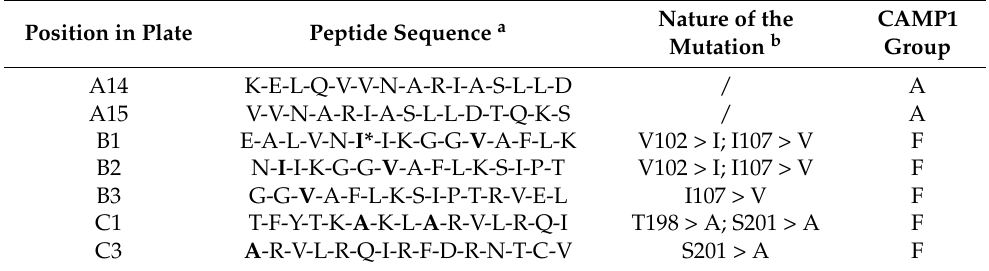
Table 1. CAMP1 peptide sequence recognized by TLR-2. Position in